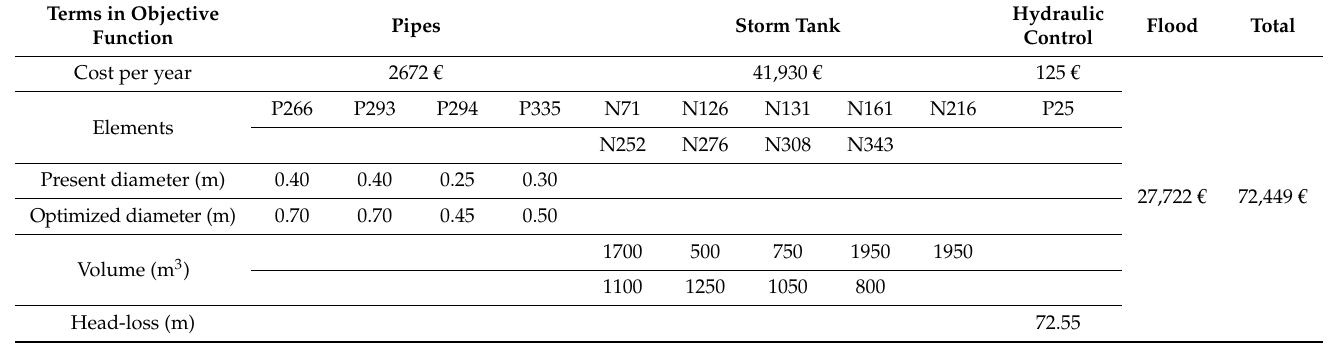
Figure 13. SSR in the ES-N network.